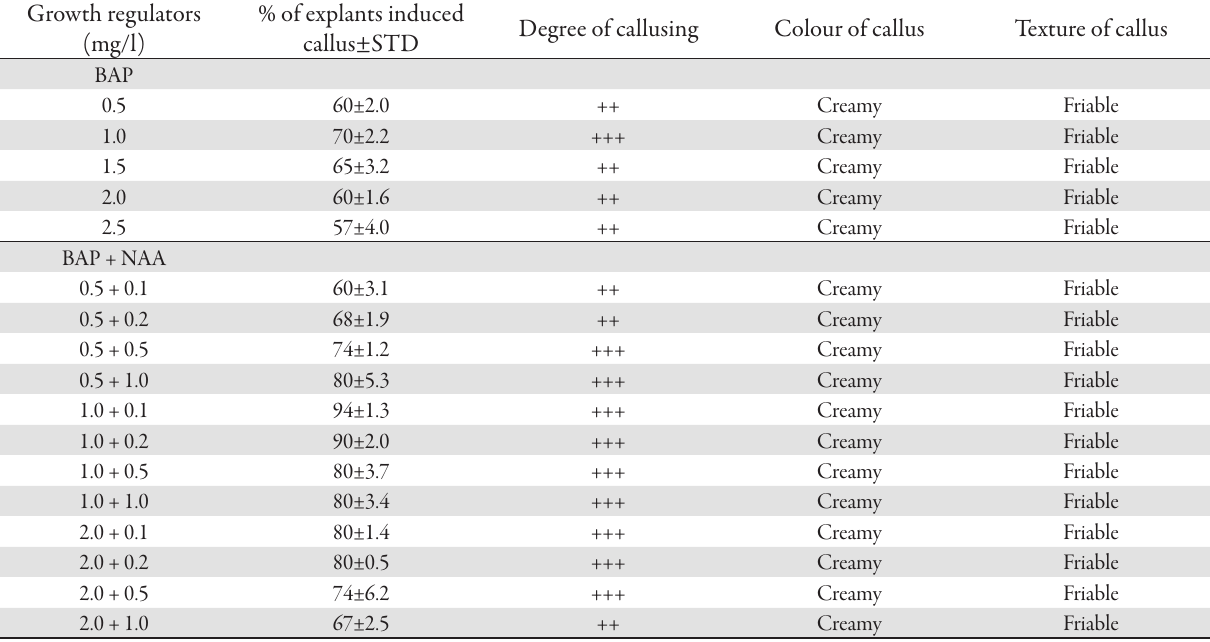
Tab. 1. Effect of growth regulators on callus induction from internodal and leaf explants Growth